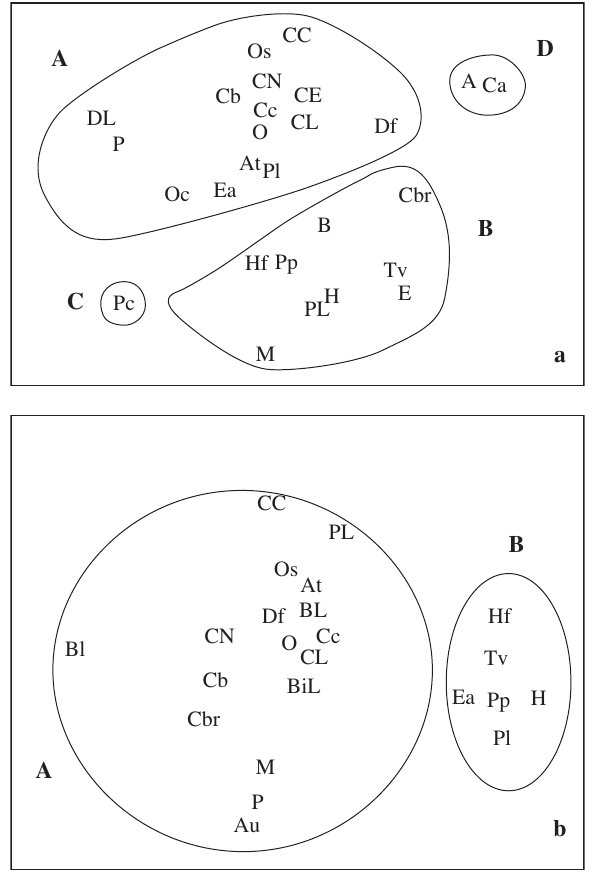
F IG . 4. – MDS plots displaying mesozooplankton assemblages for Bahía Ushuaia (a) and Bahía Golondrina (b). Ca: Calanus australis. Cbr: Centropages brachiatus. Df: Drepanopus forcipatus. Cb: Clausocalanus brevipes . At: Acartia tonsa . Ea: Eurytemora ameri- cana . Pp: Paracalanus parvus . Cc: Ctenocalanus citer . CC: Calanoida copepodids. CN: Calanoida nauplii. CE: Calanoida eggs. Oc: Oncaea curvata . Os: Oithona similis . Tv: Tisbe varians . Hf: Harpacticus furcatus . Pc: Parathalestris clausi . H: Harpacticoida spp. M: Monstrilloida sp. Pl: Podon leuckarti . Bl: Bosmina lon- girostris . A: Amphipoda. DL: Decapoda larvae. EL: Euphausiacea larvae. CL: Cirripedia spp. larvae. BL: Bryozoa larvae. P: Poly- chaeta. PL: Polychaeta larvae. A: Autolytus sp. BiL: Bivalvia larvae. O: Obelia